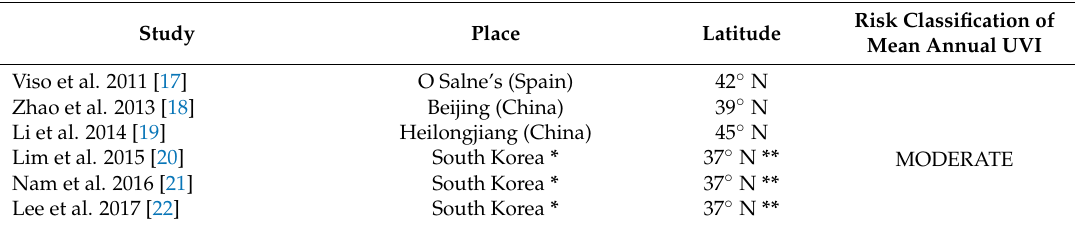
Table 1. Classification of the reviewed studies on pterygium and outdoor work classified according to the risk category derived for the mean annual UV index; 29 studies included.